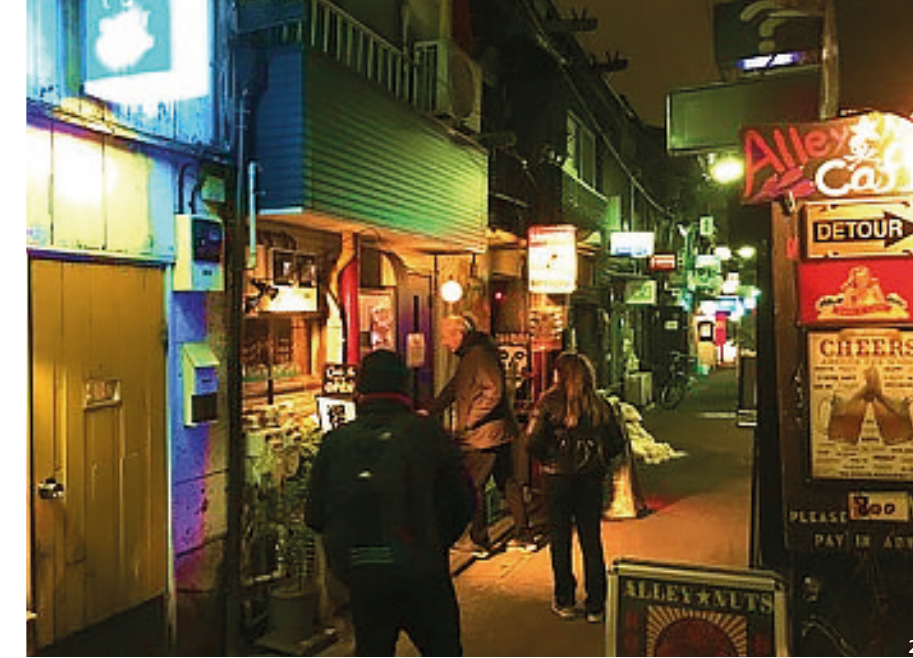
Figure 2 Tourists from around the world now crowd the narrow lanes of Golden Gai in Shinjuku (Source: the